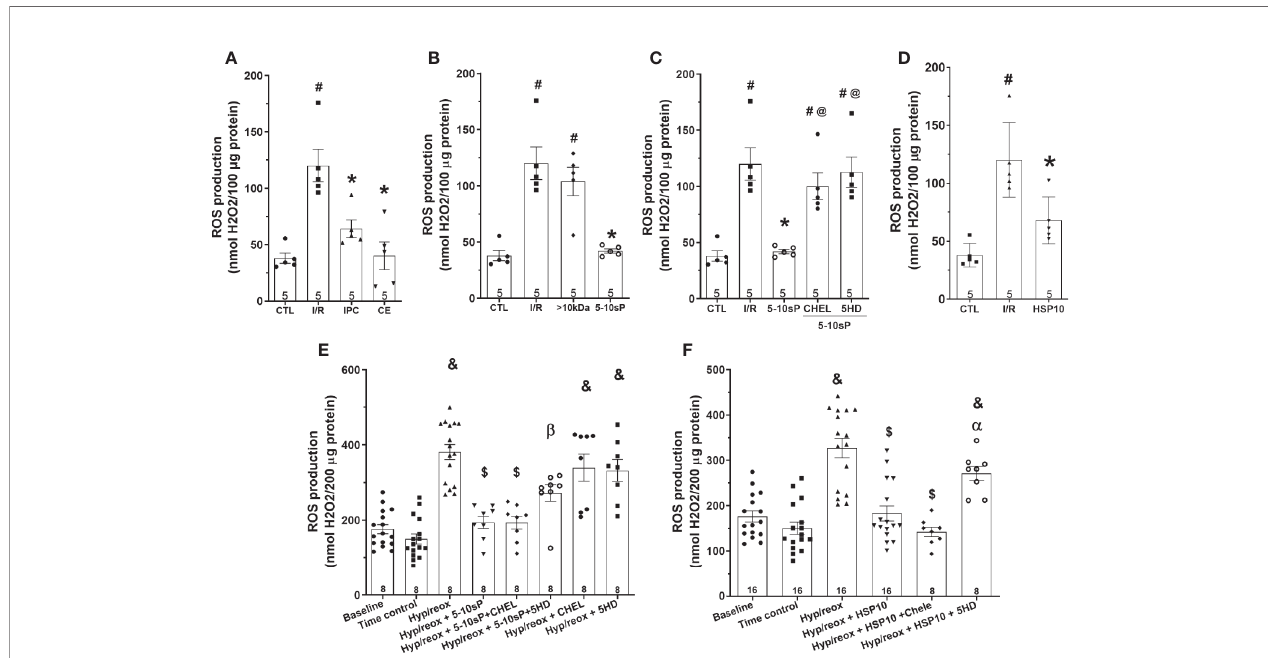
FIGURE 6 | Reactive oxygen species (ROS) production of isolated mitochondria from rat hearts. (A – D) Isolated mitochondria from hearts submitted to I/R. Control (CTL), ischemia/reperfusion (I/R), ischemic preconditioning (IPC), preconditioned coronary ef fl uent transfer (CE), coronary ef fl uent fraction 5 – 10 kDa (5 – 10-sP) transfer, coronary ef fl uent fraction >10 kDa (> 10 kDa) transfer, 5 – 10-sP plus PKC inhibitor chelerythrine or mitochondrial K ATP channel blocker 5HD. (E, F) Isolated mitochondria from hearts submitted to I/R under 10 kDa-mitochondrial heat shock protein (HSP10) perfusion. Mitochondria respiration submitted to hypoxia/ reoxygenation and (F) HSP10 or (E) 5 – 10-sP with or without chelerythrine or 5HD incubation. Number in each column is n of hearts. # P < 0.05 vs . CTL, *P < 0.05 vs . I/R, @ P < 0.05 vs . 5 – 0 kDa, & P < 0.05 vs . Time control, $ P < 0.05 vs . hypoxia/reoxygenation, a P < 0.05 vs . hypoxia/reoxygenation + HSP10, b P < 0.05 vs . hypoxia/reoxygenation + 5 –